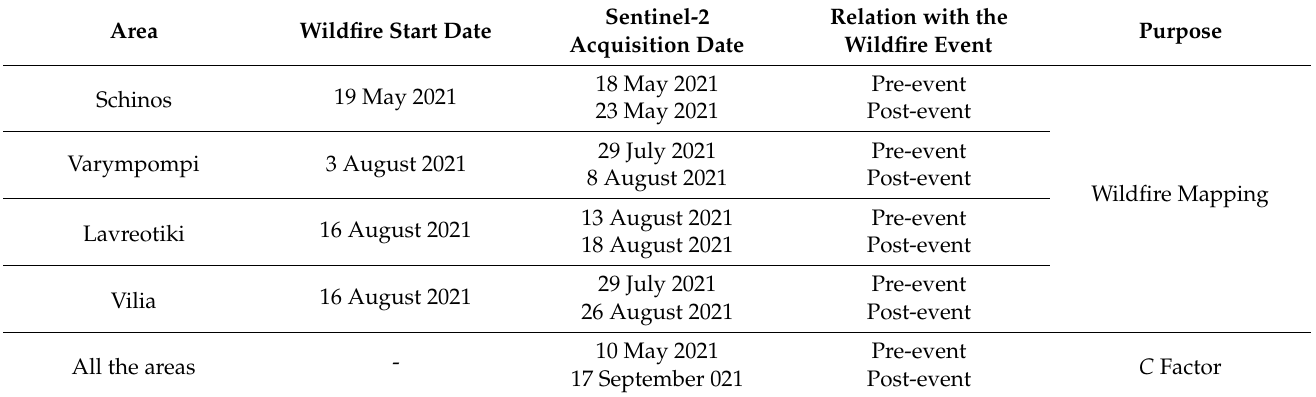
Table 2. List of used Sentinel-2 acquisitions for each area and